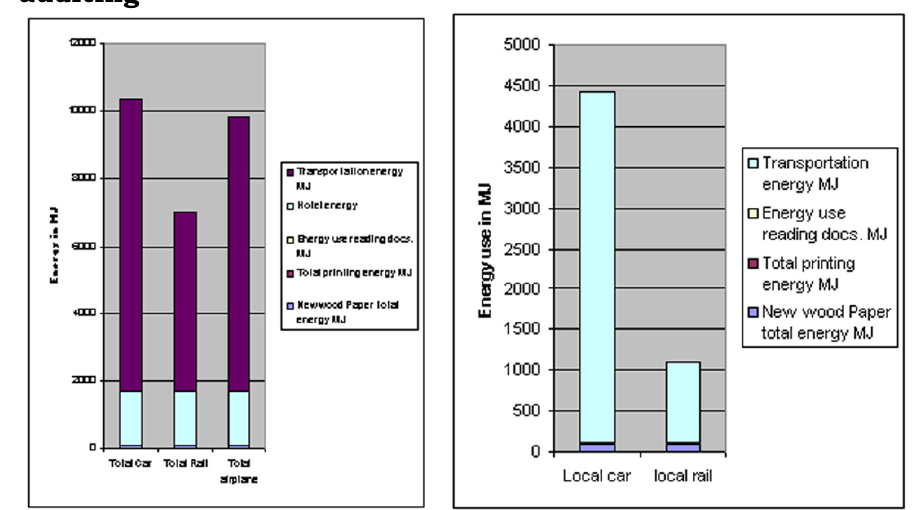
Figure 6: Energy Use for the different activities of traditional